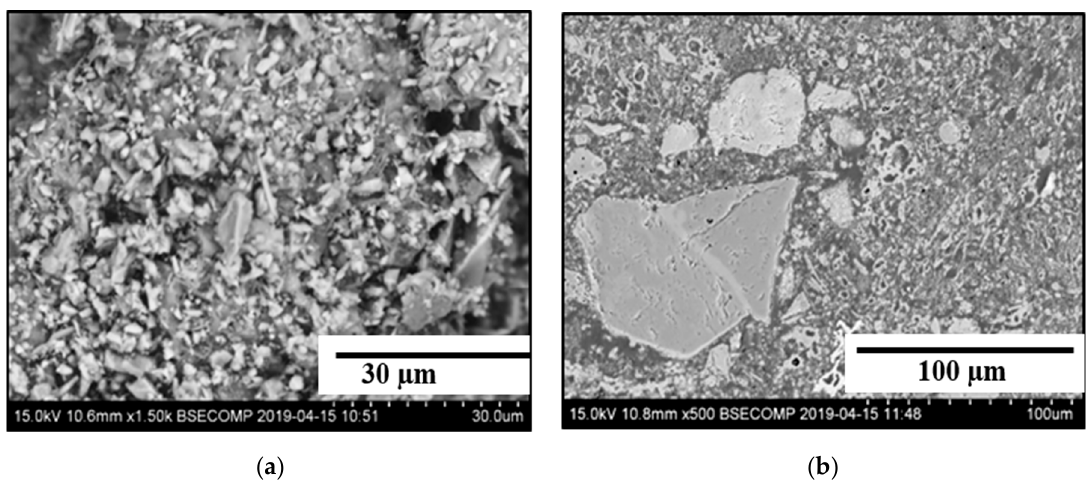
Figure 9. Typical scanning electron microscopy (SEM) images of small particles ( a ) and large blocks ( b ) in investigated powders and briquettes.